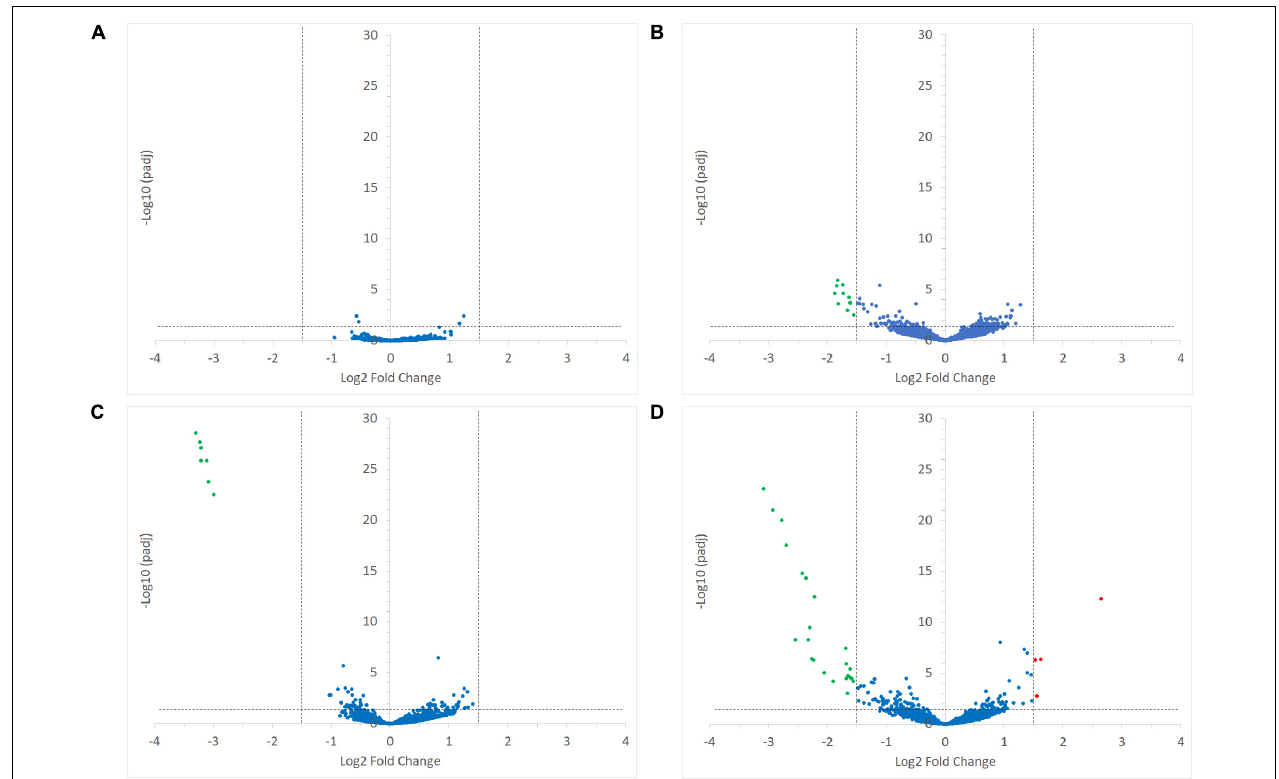
FIGURE 5 | Volcano plots representing the differential expression analysis of R. bromii L2-63 genes. Genes are considered to be differentially expressed when Log2 Fold Change < –1.5 or > 1.5 and padj < 0.05; non-differentially expressed genes are shown as blue dots. The impact of starch on R. bromii L2-63 gene transcription in mono-cultures and co-cultures is shown in panel (A,B) , respectively. (A) No gene was differentially expressed between both mono-cultures. (B) When comparing the co-cultures, 11 genes were up-regulated with RS as compared to SS (shown as green dots). The impact of R. gnavus ATCC 29149 on R. bromii L2-63 gene transcription with SS and RS as sole carbon source is shown in panel (C,D) , respectively. (C) When SS was used as carbon source, 7 genes were up-regulated in the co-culture as compared to the mono-culture (shown as green dots). (D) When RS was used as carbon source, 23 genes were up-regulated in the co-culture (shown as green dots) while 4 genes were upregulated in the mono-culture (shown as red